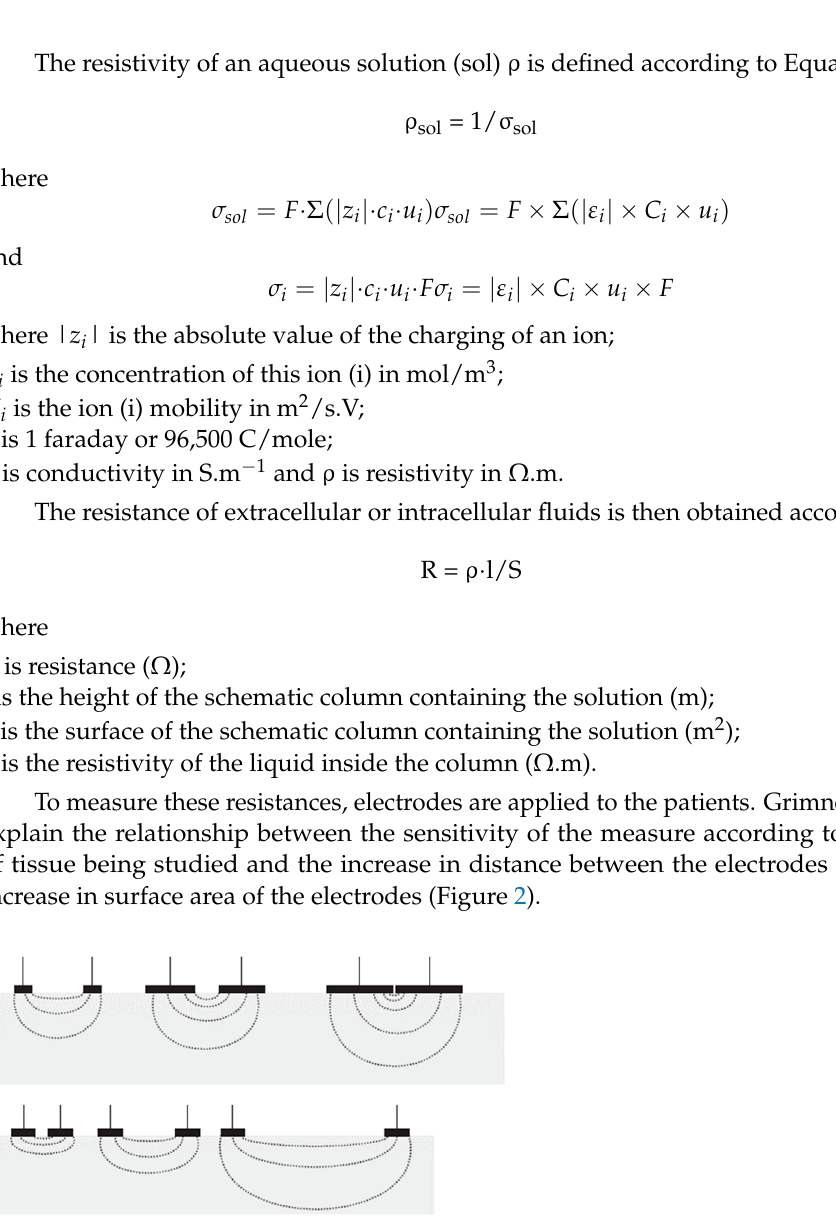
Figure 2. Sensitivity in deep layers according to the distance and the dimensions of the electrodes